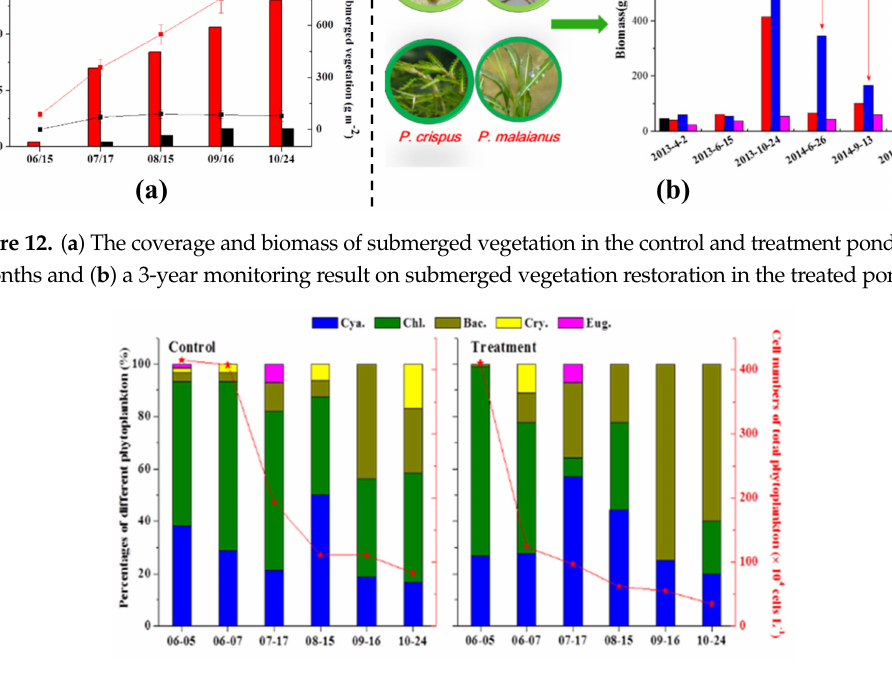
Figure 13. Changes of the dominant phytoplankton composition in the control and treatment